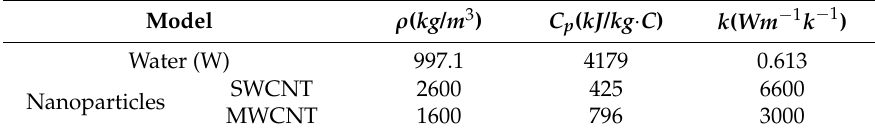
Table 1. The thermophysical properties of CNTs and the base fluid water.